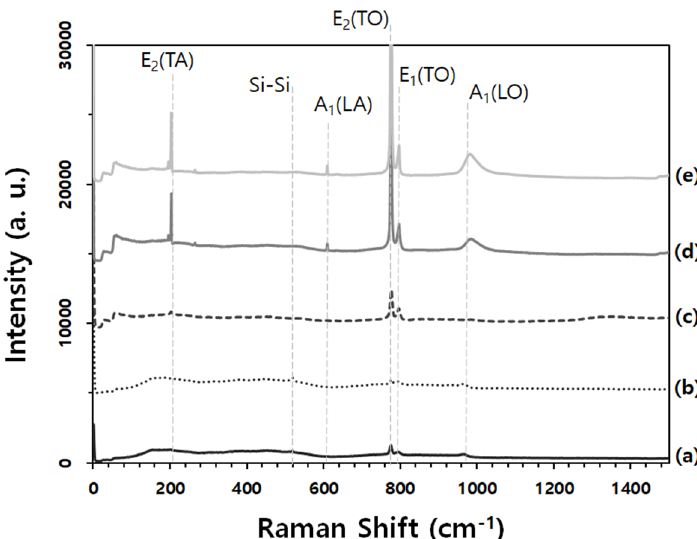
Figure 7. Raman spectra of the SiC films deposited under five di ff erent conditions: ( a ) without bias and at a gas ratio of (SiH 4 + CH 4 ) / H 2 of 0.04, ( b ) with bias of + 50 V and at a gas ratio of (SiH 4 + CH 4 ) / H 2 of 0.04, ( c ) with bias of − 50 V and at a gas ratio of (SiH 4 + CH 4 ) / H 2 of 0.04, ( d ) with bias of − 50 V and at a gas ratio of (SiH 4 + CH 4 ) / H 2 of 0.01 and ( e ) with bias of − 50 V, a gas ratio of (SiH 4 + CH 4 ) / H 2 of 0.01 and a distance of 2 mm between the wires and the substrate.